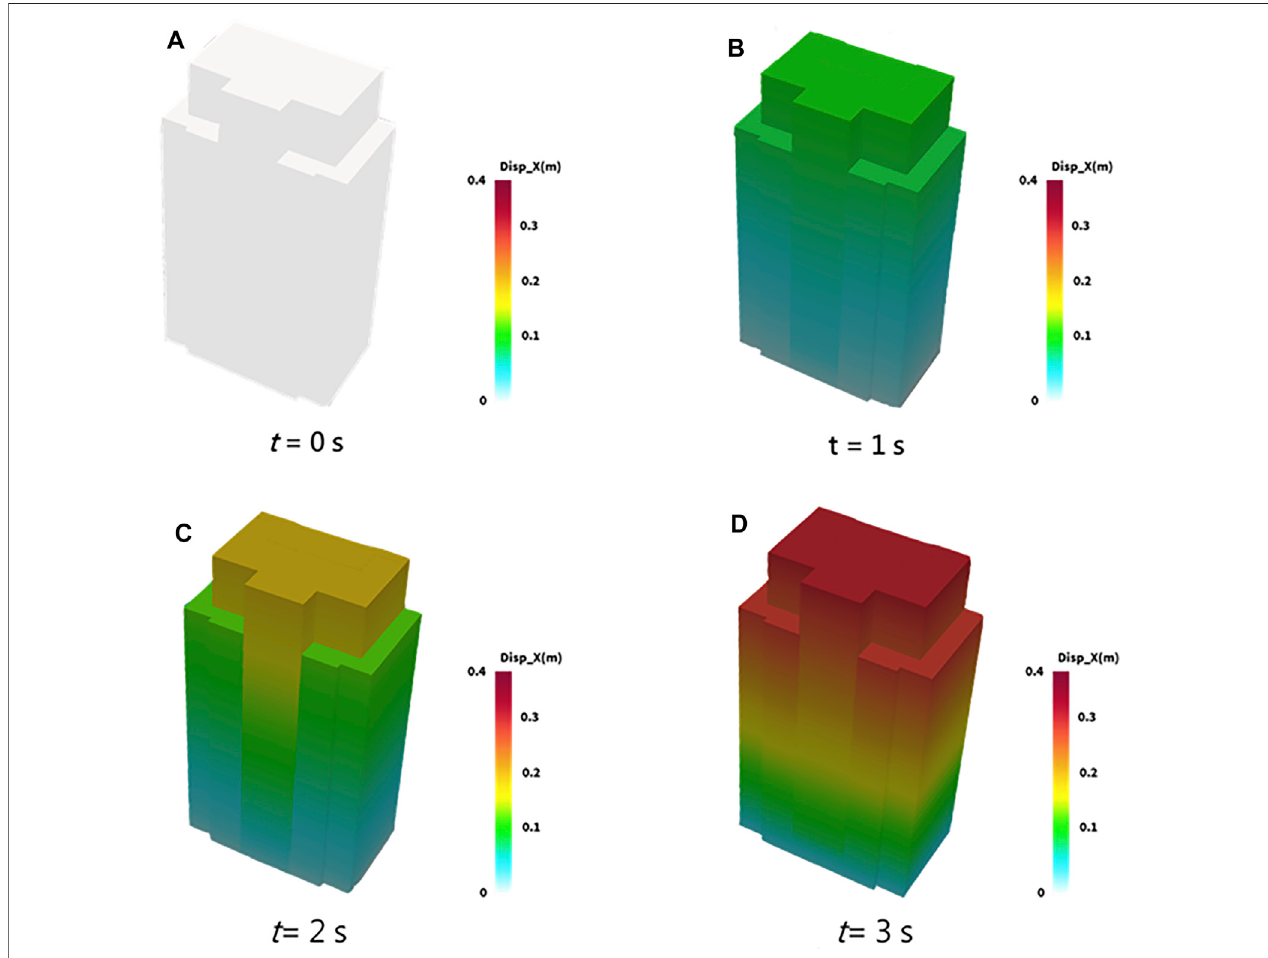
FIGURE 9 | Dynamic seismic analysis of building deformation and displacement (A) t = 0 s, (B) t = 1 s, (C) t = 2 s, (D) t = 3 s.